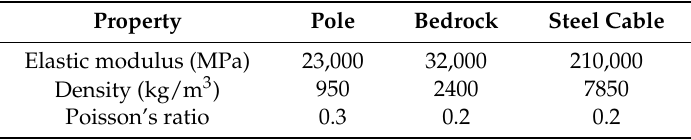
Table 3. Material properties for three structural components.